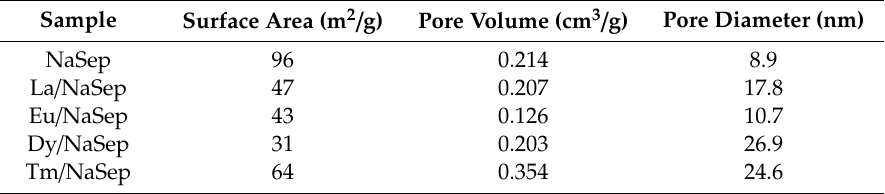
Figure 3. N 2 adsorption–desorption isotherms of the samples. Table 1. BET surface areas, pore volumes, and pore diameters.